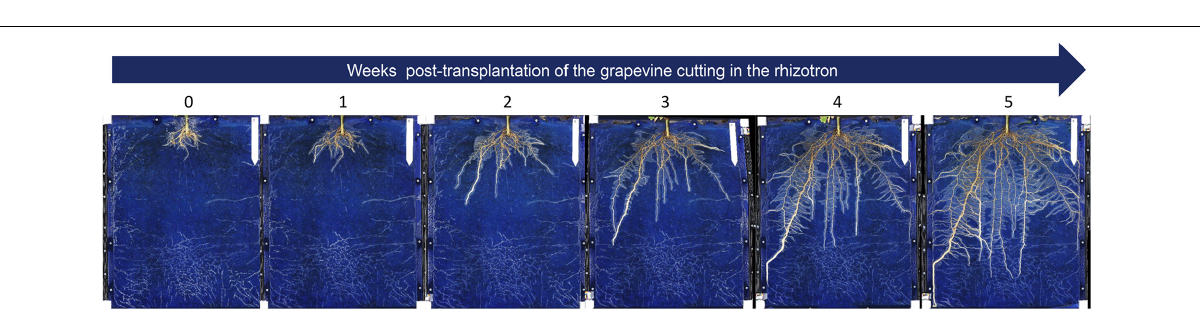
FIGURE 4 | Root development over time of a pre-rooted grapevine herbaceous cutting grown in a rhizotron. The root development was followed during 5 weeks after transplantation of the cutting in the rhizotron (1 picture per week). The landmark at the top right side corresponds to 12 cm.